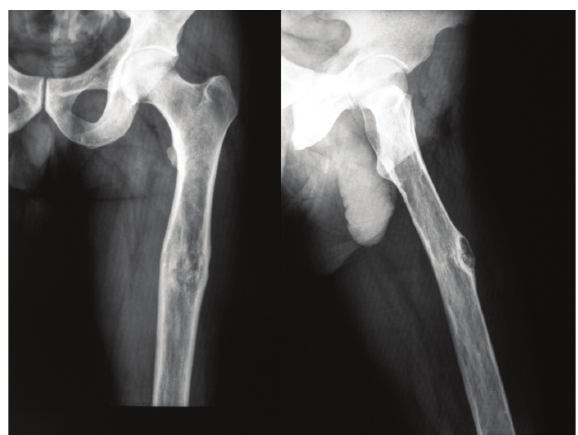
Figure 1: Plain radiographs of the left femur demonstrating moderate expansion in bone, including lytic areas with a cortical defect at the anterolateral aspect of the upper third of the left femoral shaft and cortical